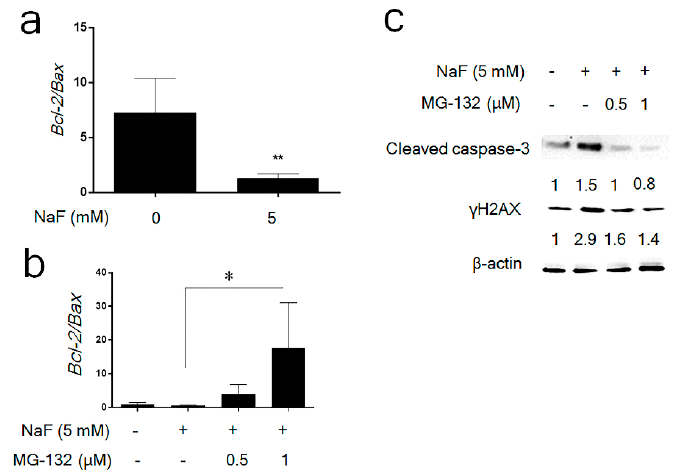
Figure 3. MG-132 attenuated fluoride-induced apoptosis in LS8 cells. LS8 cells were treated with MG-